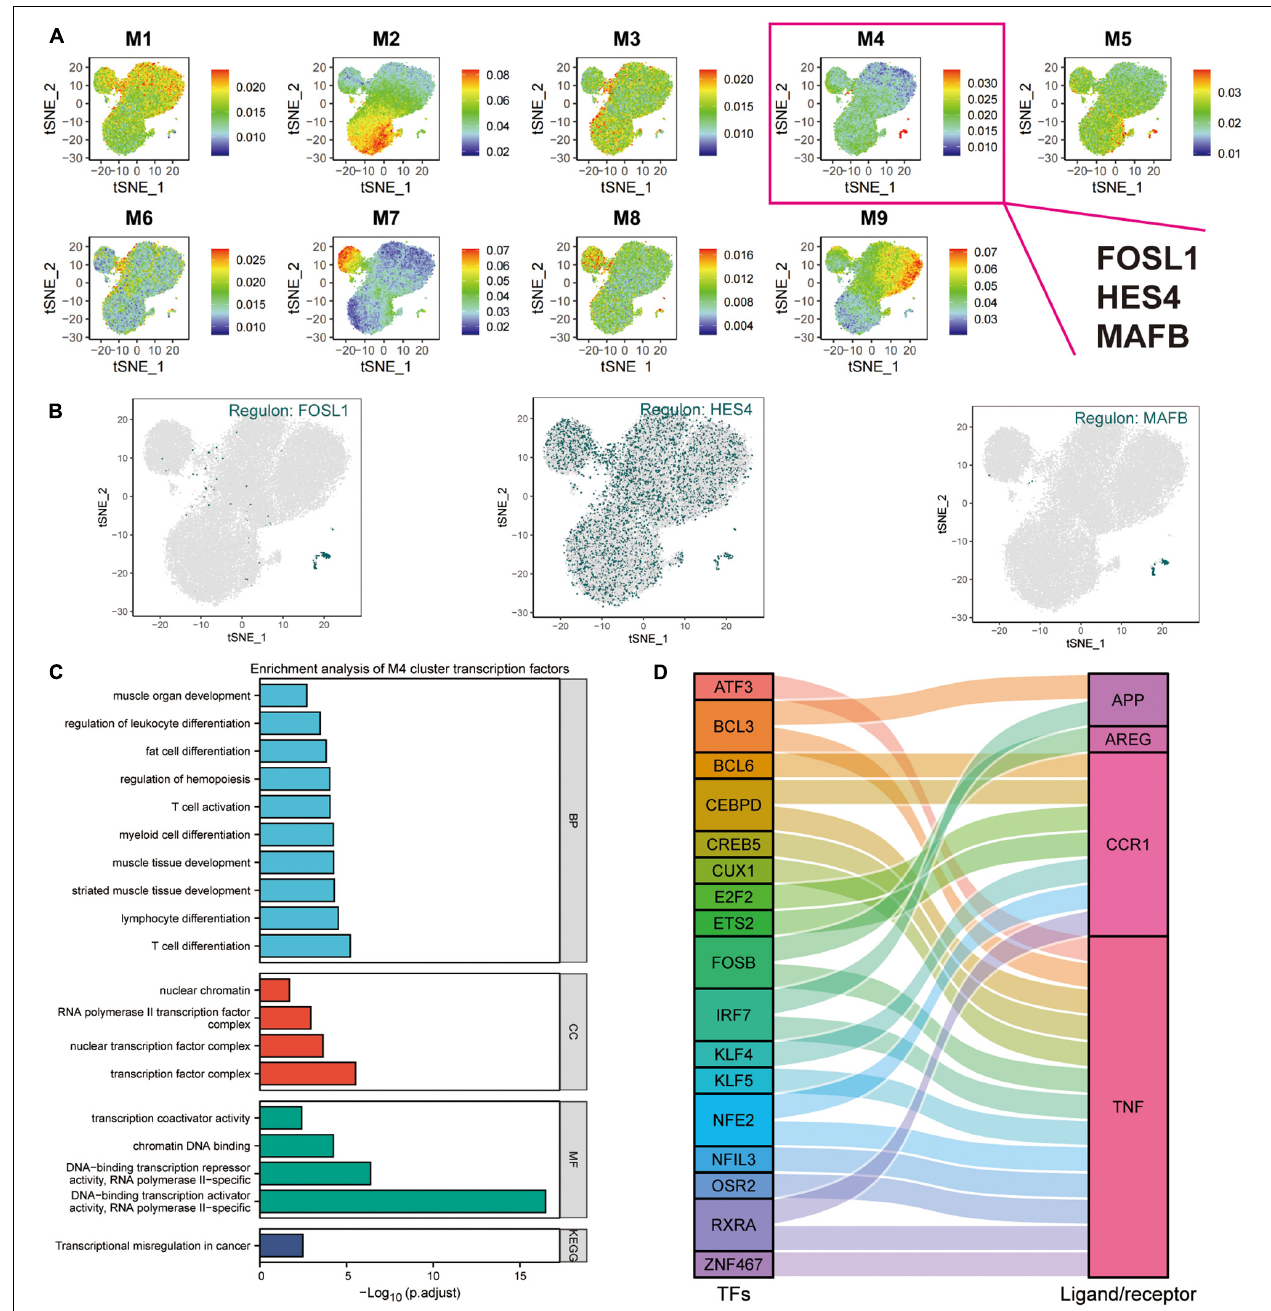
FIGURE 6 | Cluster analysis of target genes in exercise-regulated AD monocytes. (A) The transcriptional activity profile of the M1–M9 module is illustrated using t-SNE plots, where FOSL1 , HES4 , and MAFB are the signature transcription factors of the M4 module; (B) Expression profiles of key transcription factors FOSL1 , HES4 , and MAFB are shown using t-SNE plots; (C) GO and KEGG enrichment analysis of M4 transcription factor clusters; (D) Sangi diagram demonstrating the key ligands or receptors that may be regulated by the transcription factors in the M4